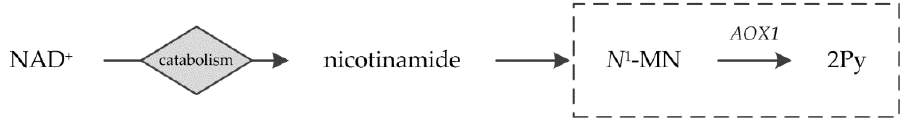
Figure 1. Schematic overview of NAD + catabolism. 2Py is the end product of NAD + catabolism after AOX1-dependent oxidation of N 1 -MN, framed by the dotted line. AOX1, aldehyde oxidase; N 1 -MN, N 1 -methylnicotinamide; 2Py, N 1 -methyl-2-pyridone-5-carboxamide.